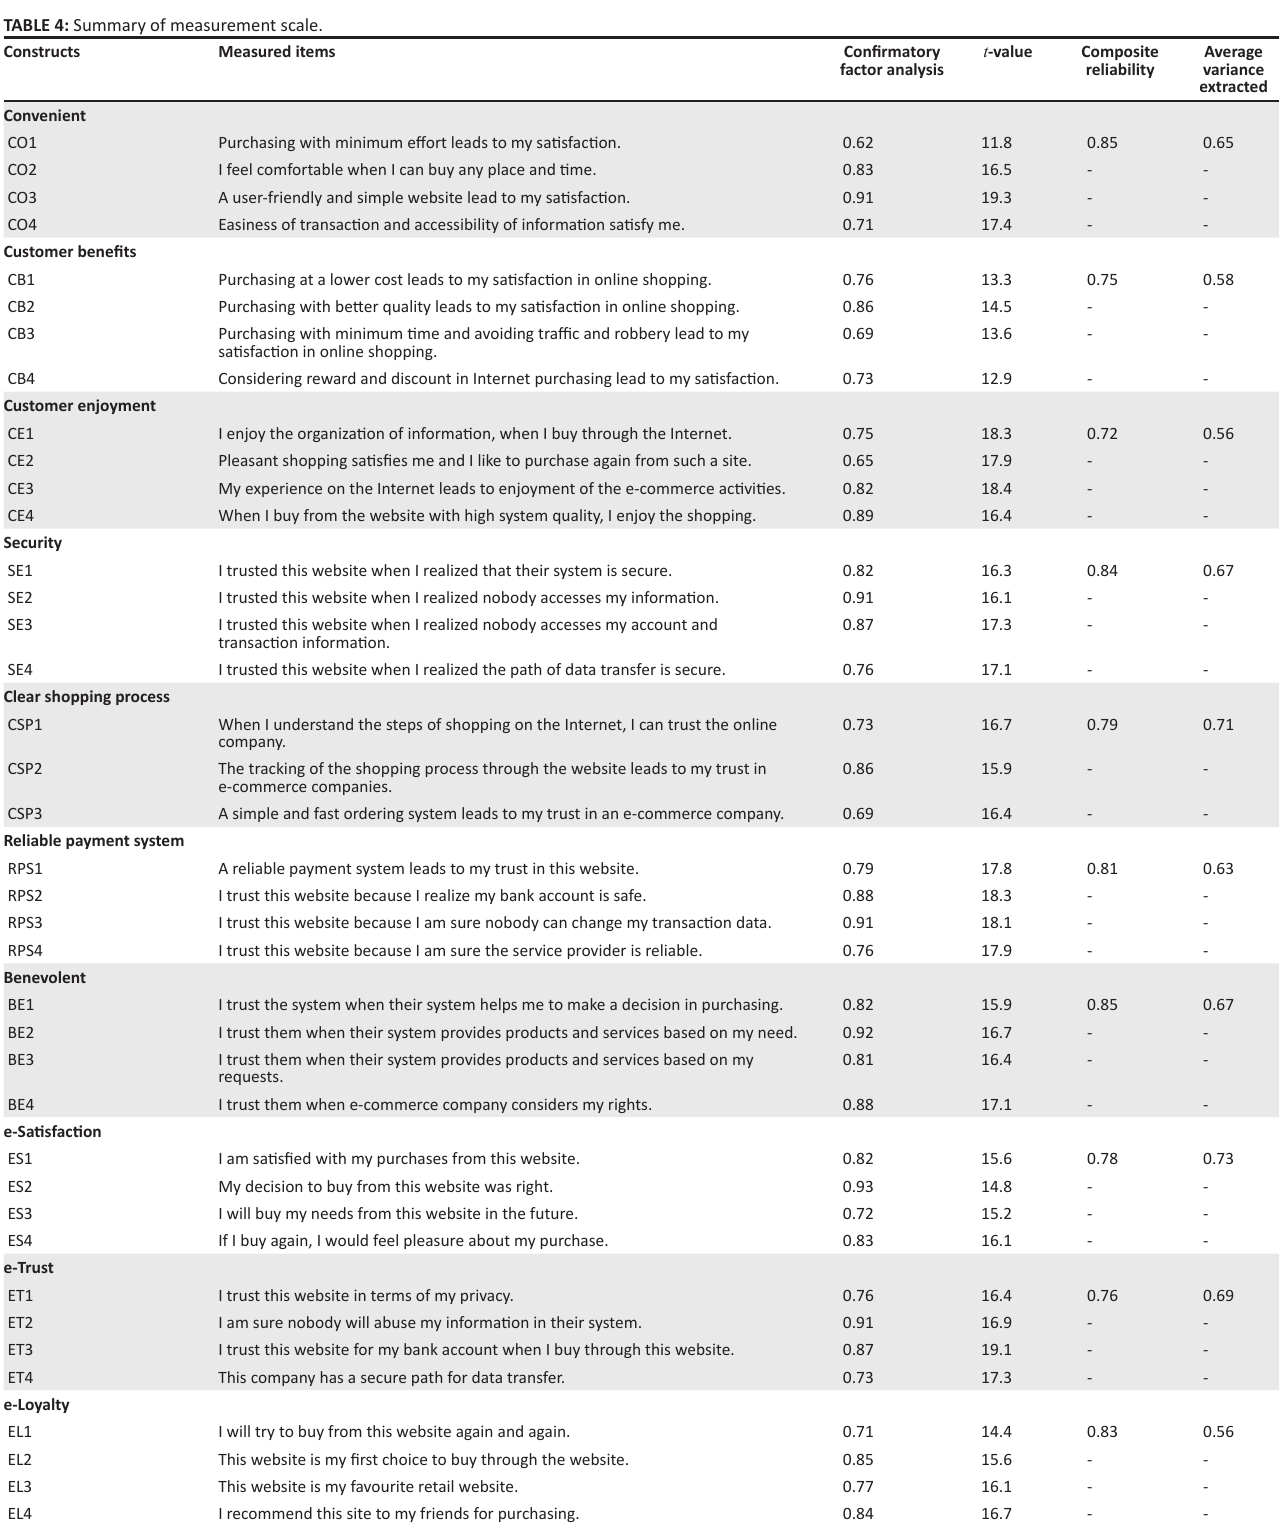
TABLE 4: Summary of measurement scale. Constructs Measured items Confirmatory